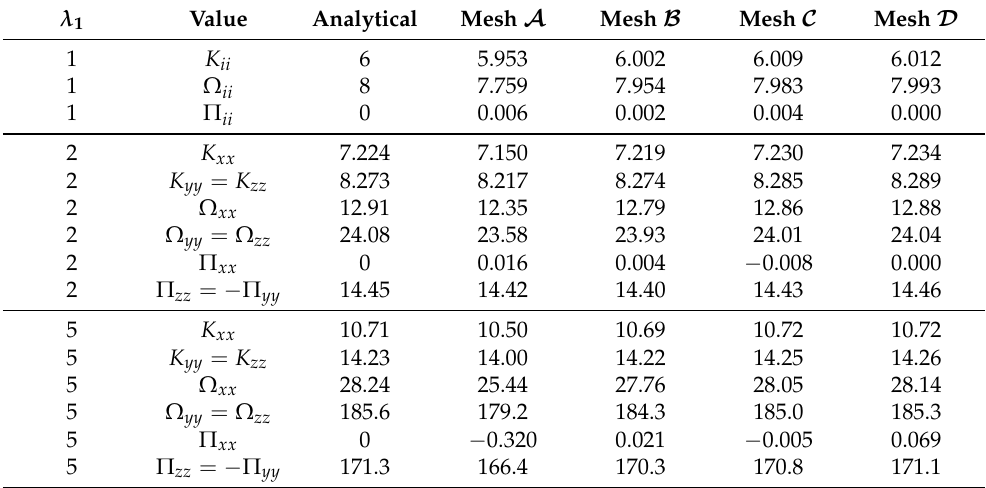
Table 1. Comparison of the analytical and numerical values of the translation and rotation tensors in the case of a sphere and two prolate ellipsoids. λ